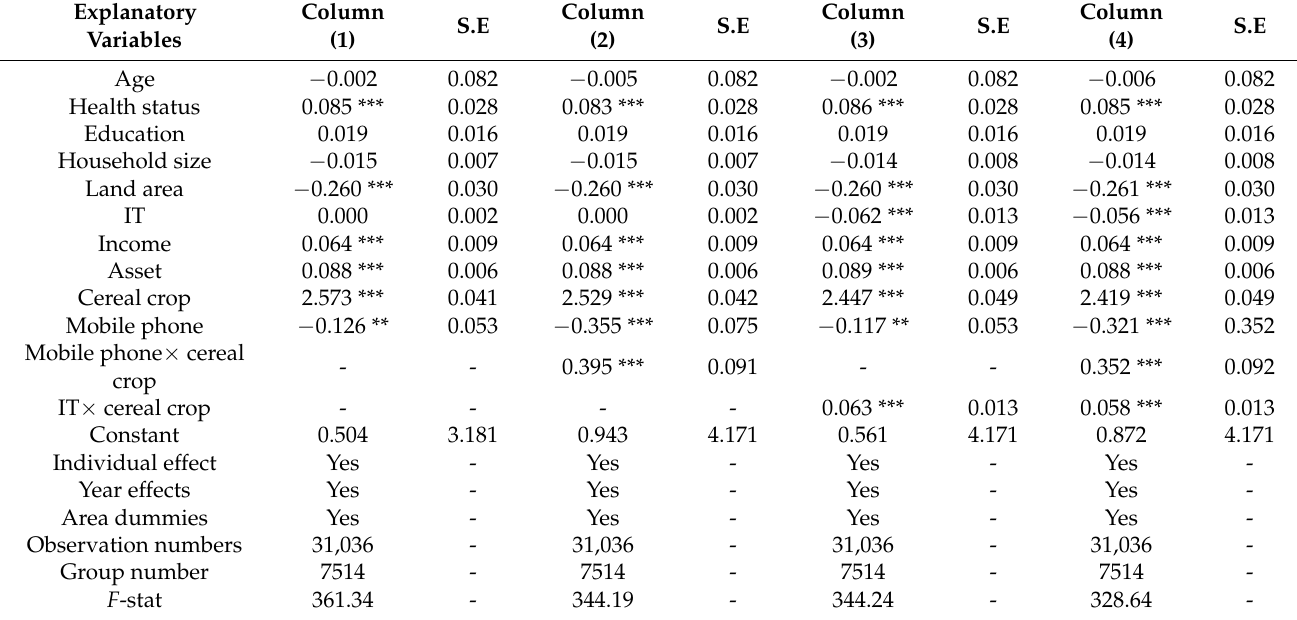
Table 2. Influences of mobile phones on inorganic fertilizer